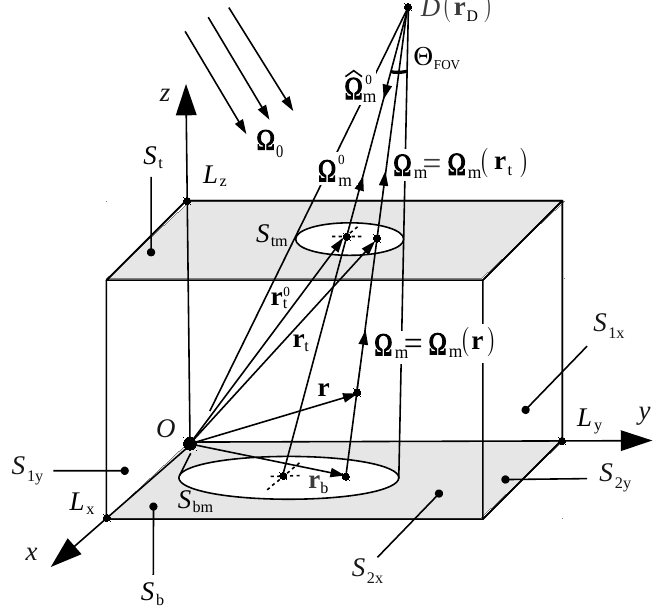
Figure 1. Illustration of the radiative transfer